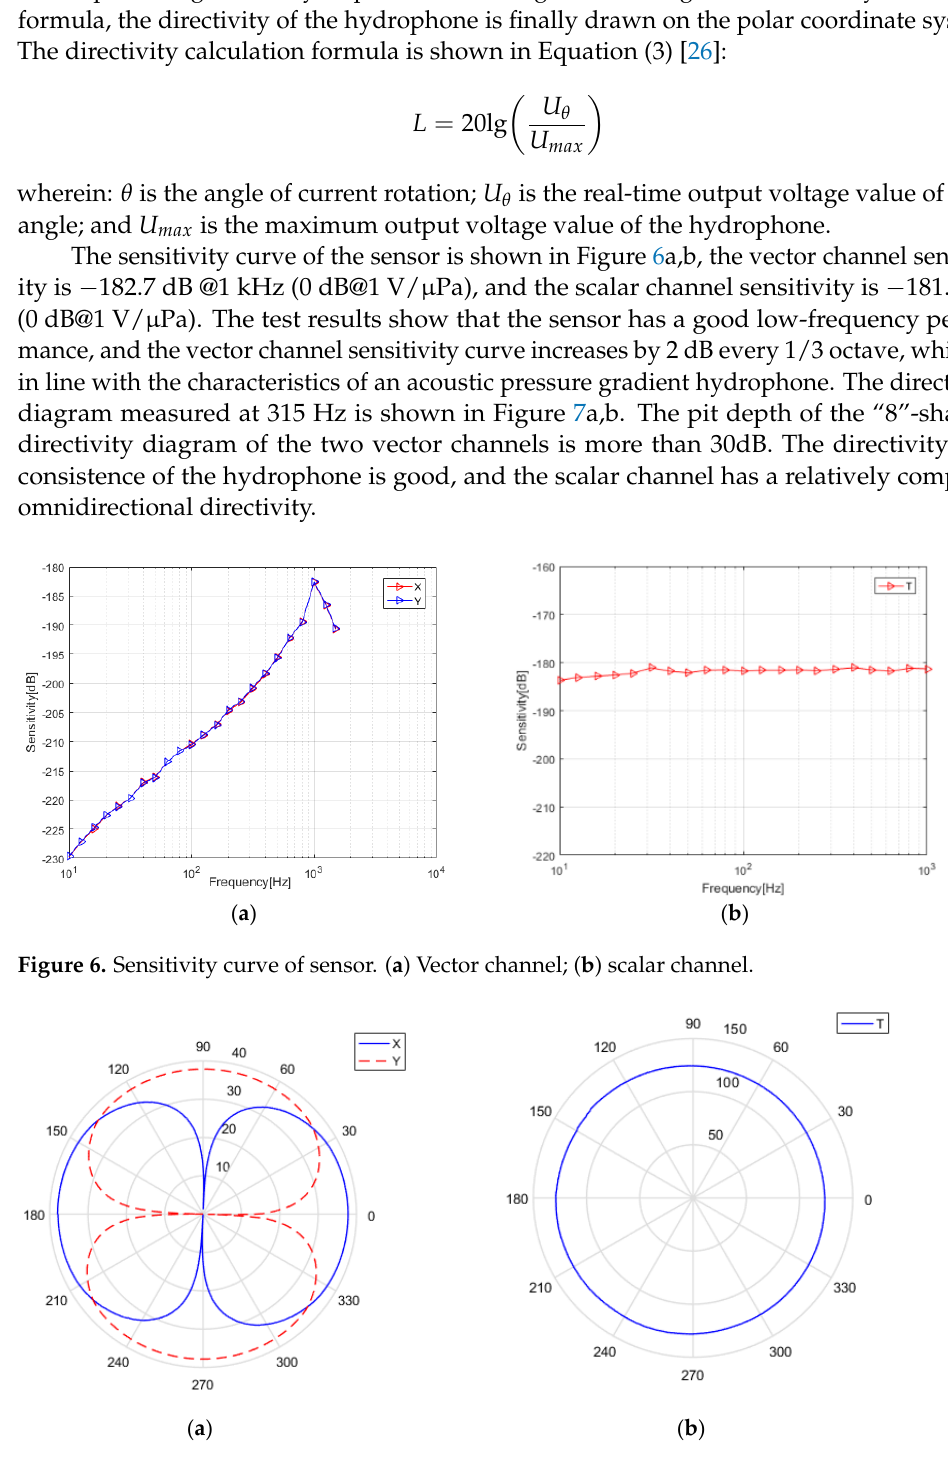
Figure 5. Schematic diagram of hydrophone calibration system.